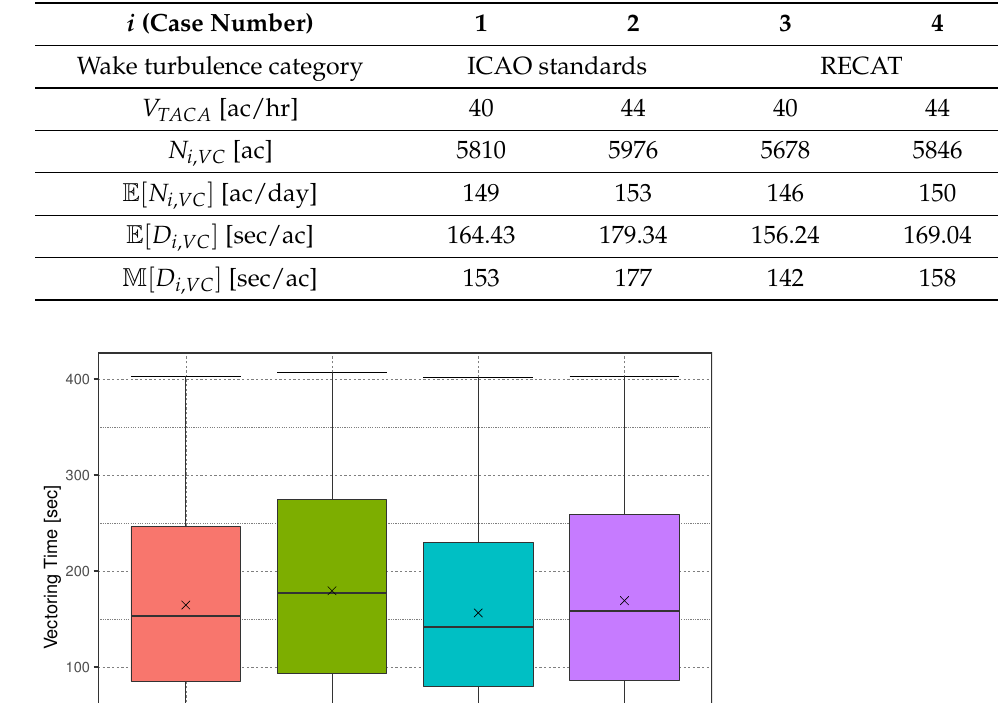
Table 10. Summary of vectoring delay per flight on ML-PM1 depicted in Figure 6.